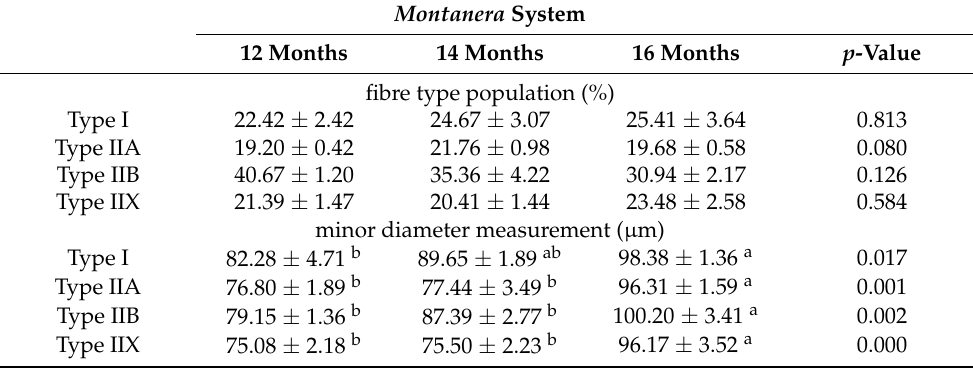
Table 2. Muscle fibre population and size of m. Longissimus thoracis from Iberian × Duroc crossed animals reared under the Montanera system according to slaughter age.